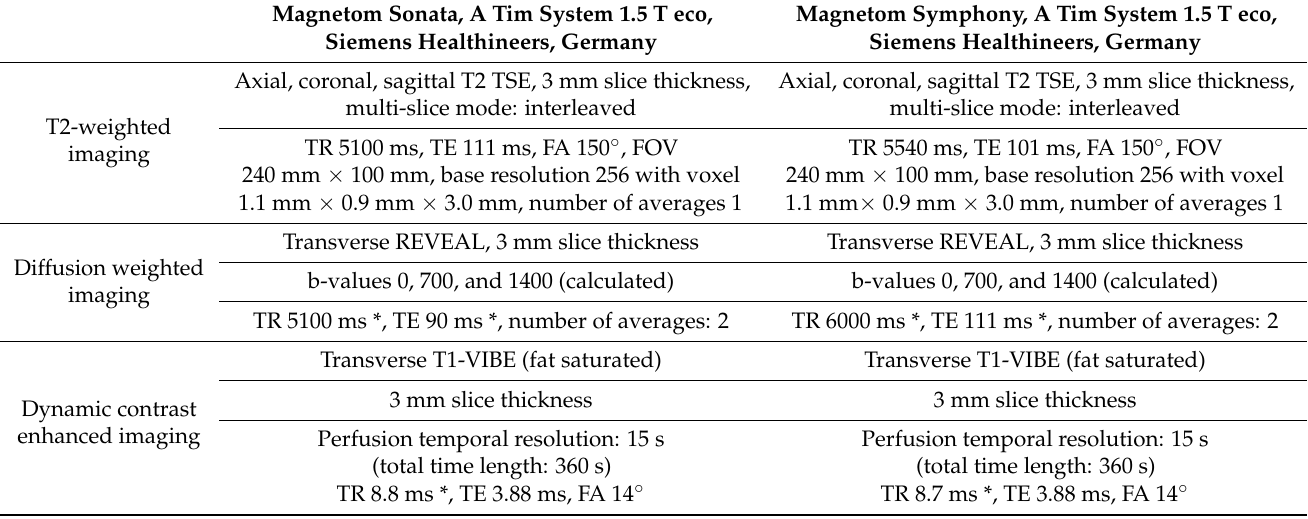
Table 1. MRI Parameters: mpMRI acquisition parameters. Differences in parameters between two scans, noted with *, were considered